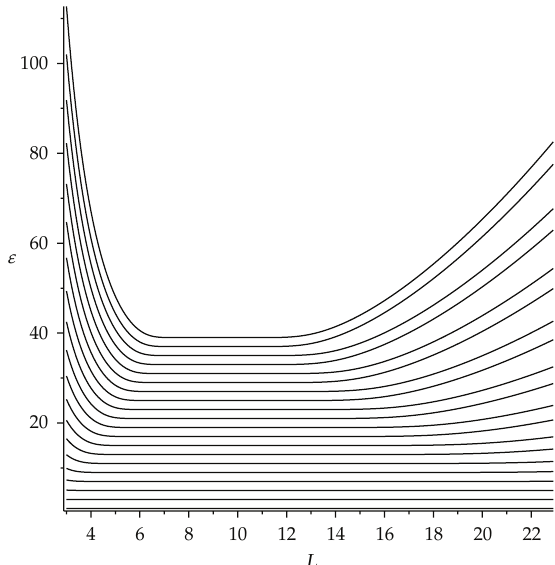
Figure 1: Graph of the eigenvalues 𝜀 of the matrix H as functions of variational parameter 𝐿 for fixed 𝑁 = 50